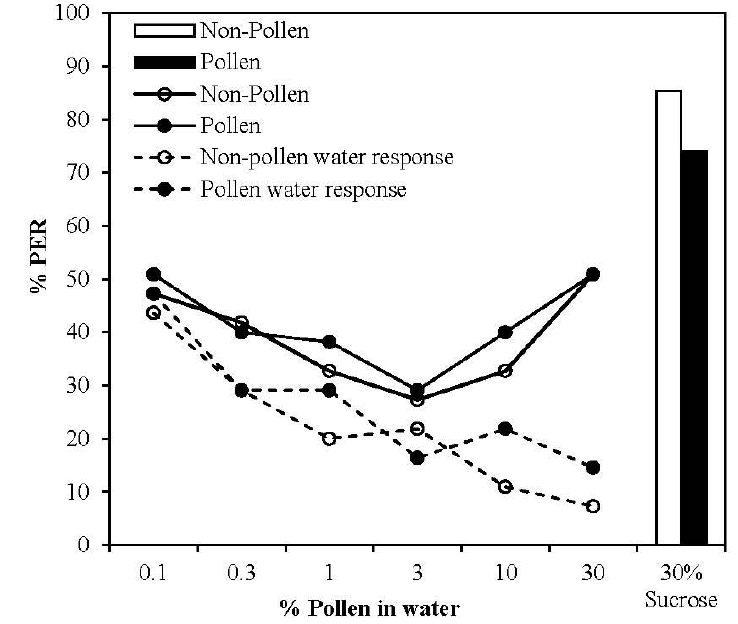
Figure 3. Proportion of bees extending the proboscis to antennal stimulation with a series of pollen-water mixtures, tested in order of ascending pollen concentration. Bees were separated according to forager type (Black circles = Pollen foragers, n = 53 Open circles = Non-pollen foragers, n = 55). Bars represent the response to a final stimulation with 30% sucrose (White = pollen foragers, Black = non-pollen foragers). The dashed lines represent bees (cid:182) responses to water stimulation prior to the stimulation with each pollen concentration (Black triangles = pollen foragers, Open triangles = non-pollen